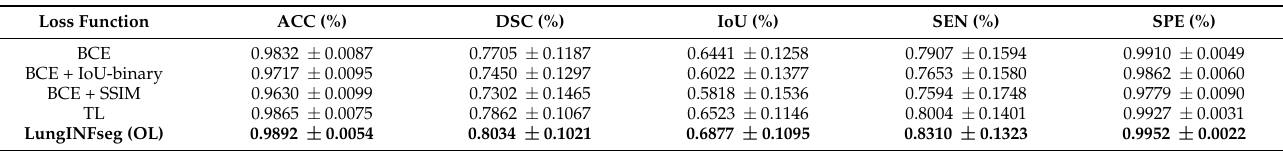
Table 5. The evaluation of the LungINFseg with different loss functions on the test set (mean ± standard deviation ). Best results are in